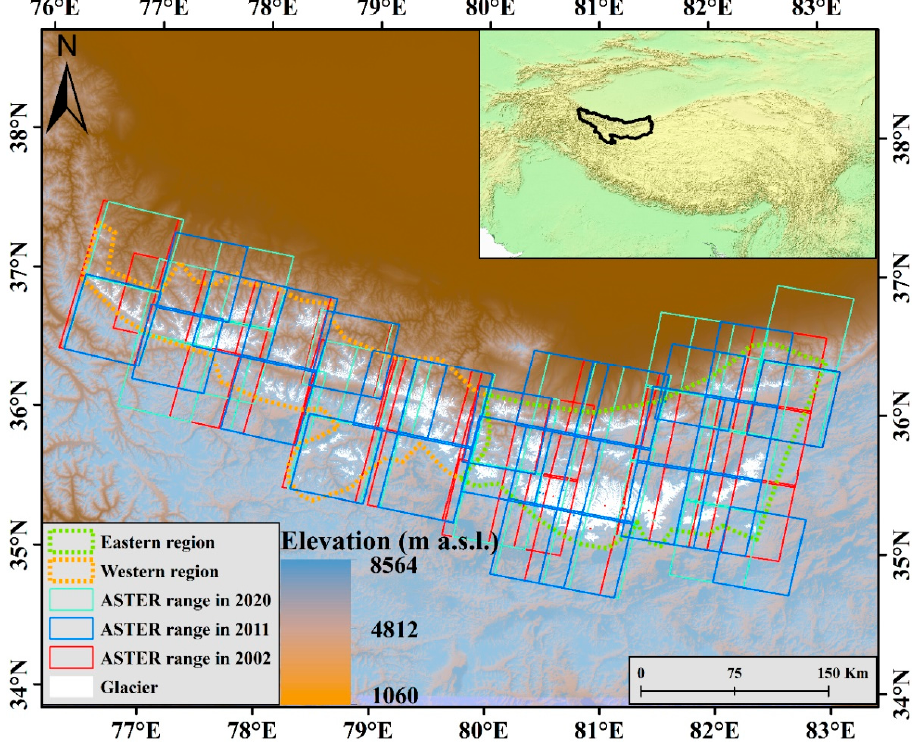
Figure 1. Overview of the study area. Sub panel: Locations of study area, West Kunlun (WK), in High Mountain Asia (HMA). Main panel: Location of glaciers in the WK and outlines of Advanced Spaceborne Thermal Emission and Reflection Radiometer (ASTER) coverage used in this study, in- cluding subdivision in Western WK and Eastern WK. Background image is Shuttle Radar Topography Mission Digital Elevation Model (SRTM DEM). We used Randolph Glacier Inventory version 6.0 (RGI v6.0) as the glacier